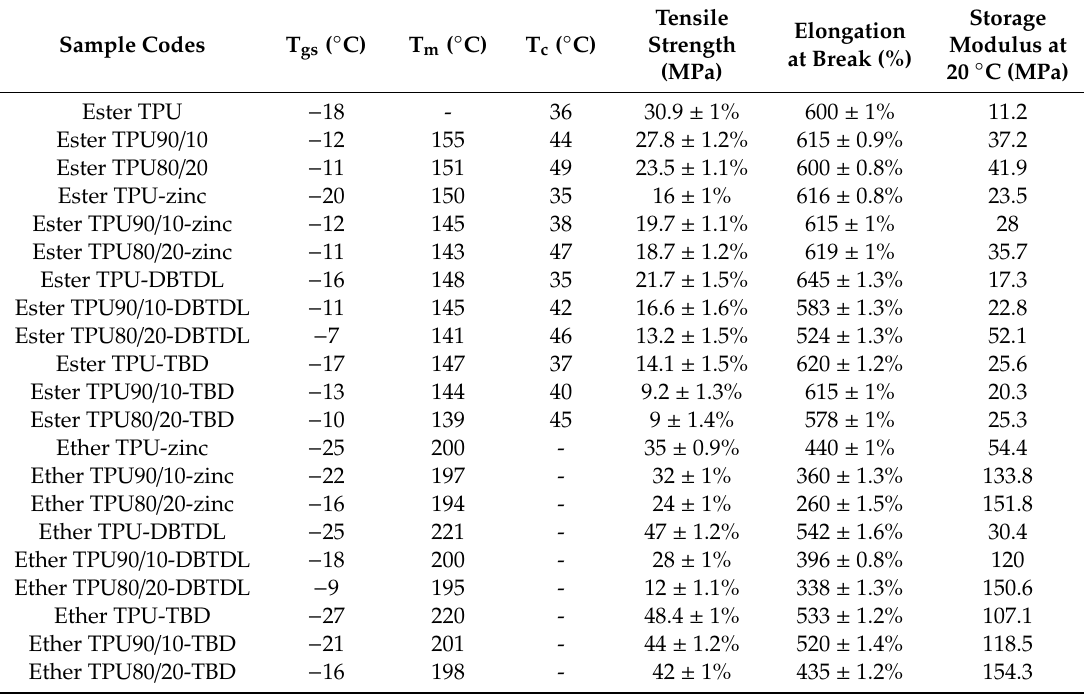
Table 2. Thermal, mechanical and dynamic mechanical properties of TPU/phenoxy resin blends.